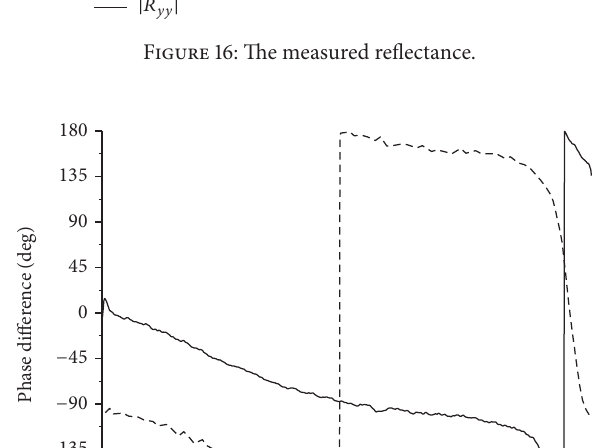
Figure 18: The measured axial